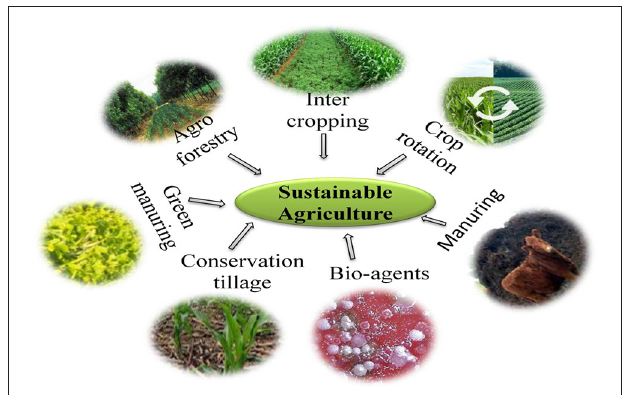
FIGURE 1 | Components of sustainable